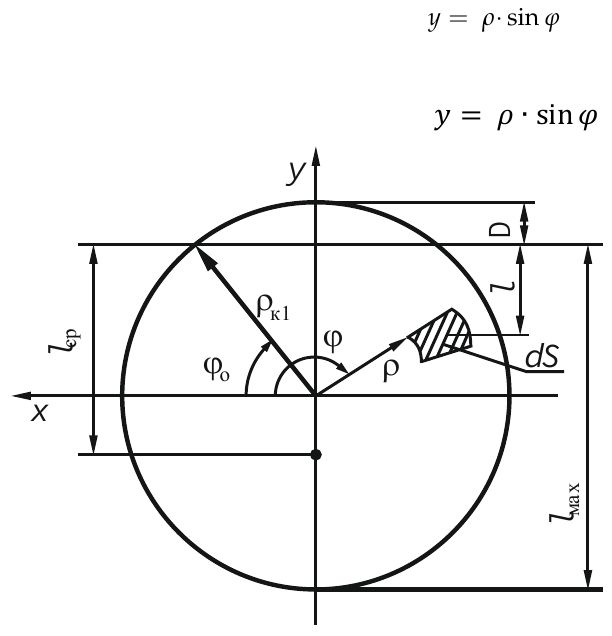
Figure 8. Schematic representation of the mixer fill-up and thickness of the material layer l to the location of the elementary area of the screw surface dS ; D is the vertical height of the mixer ullage, ρ к 1 is maximum radius of external screw of the mixer, ϕ is the angle of screw interaction with material, l cp is the averaged depth of the material layer over the screw surface S ; l max is the the maximal depth of the material layer over the screw surface S ; ϕ 0 is the initial angle of screw interaction of screw with material; and ρ is the screw radius.